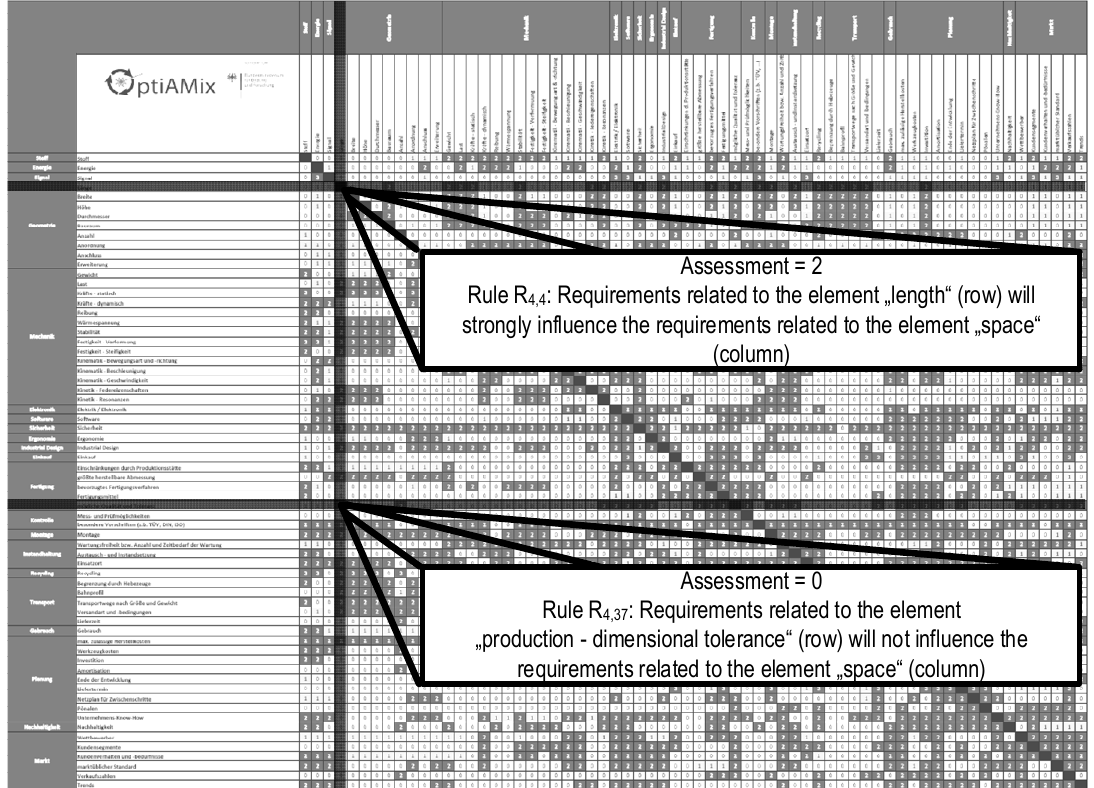
Figure 6. Rule-set for semi-automatized assessment of requirement interrelations [51].